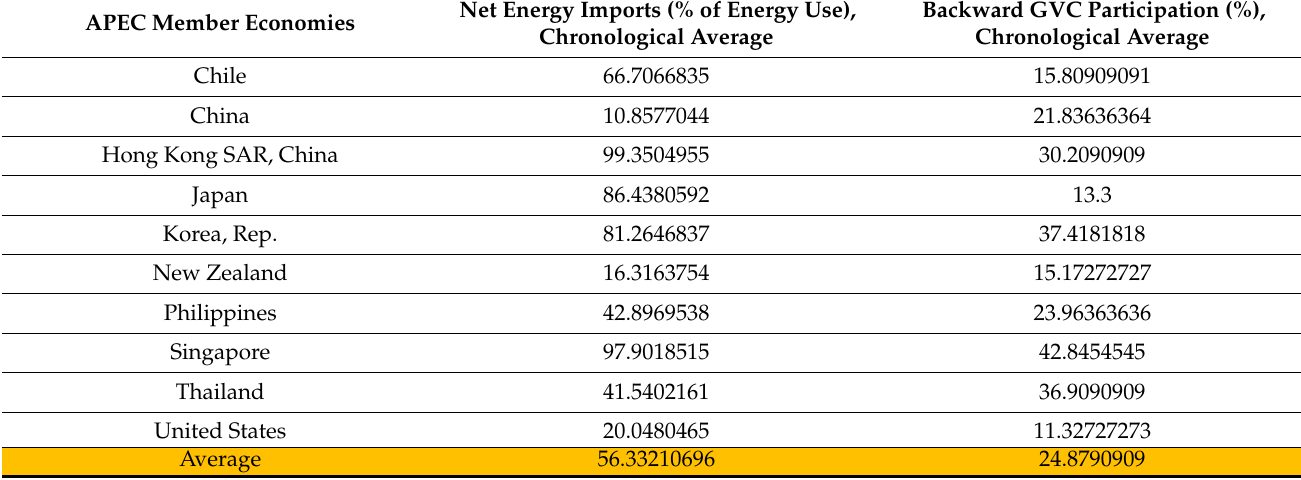
Table 10. APEC member economies—energy importers.